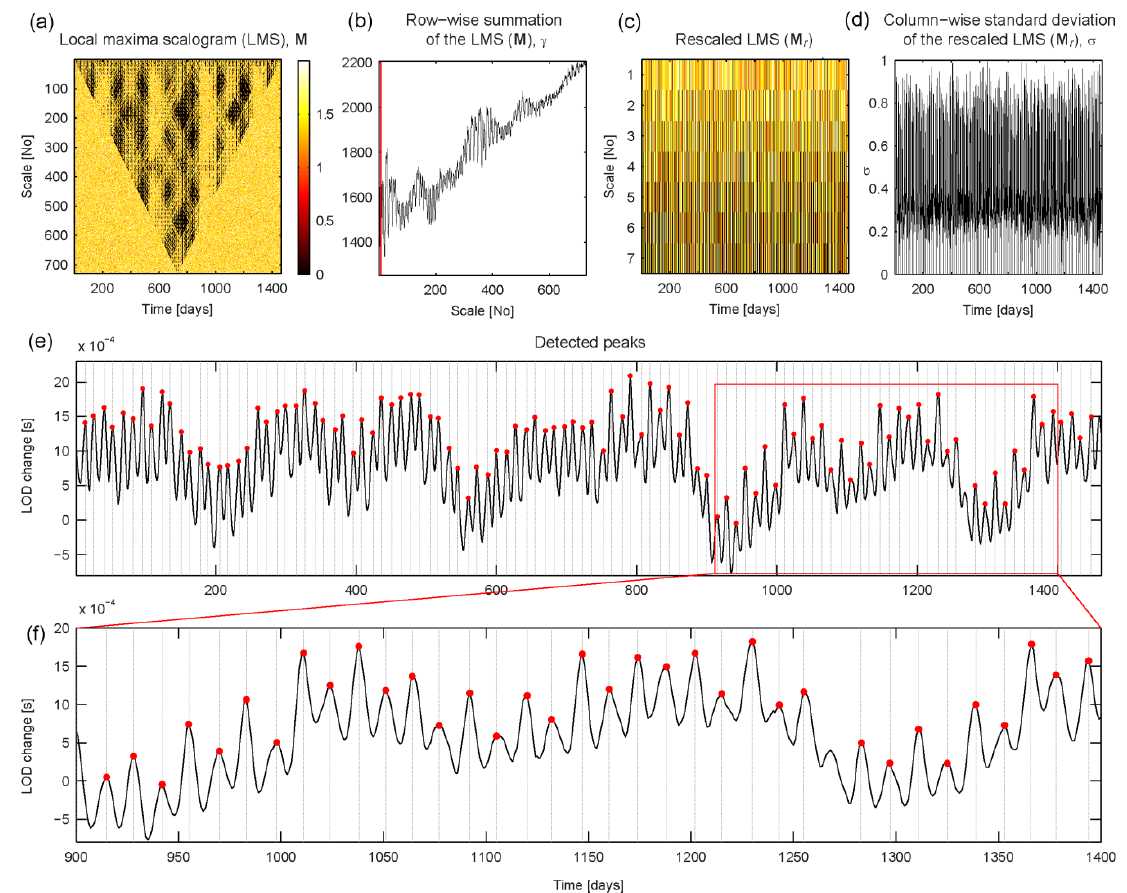
Figure 9. Results of applying the AMPD algorithm to aLOD time series.